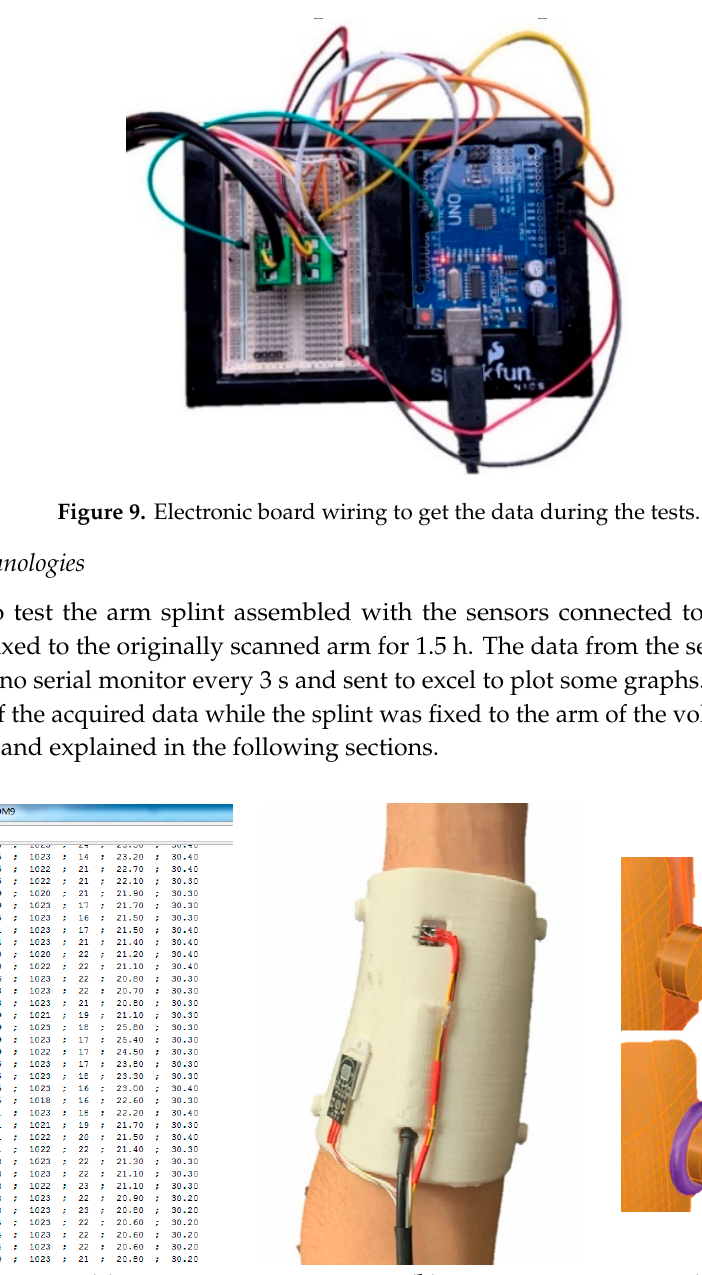
Figure 11. Temperatures graph. 32333435363738 0